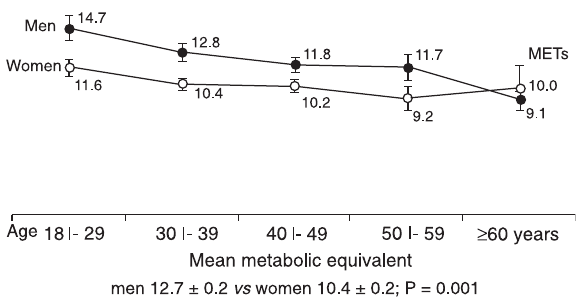
Figure 2. Mean of estimated exercise capacity in metabolic equivalents (METs) during treadmill exercise stress testing rela- tive to age and gender. (Student t -test).